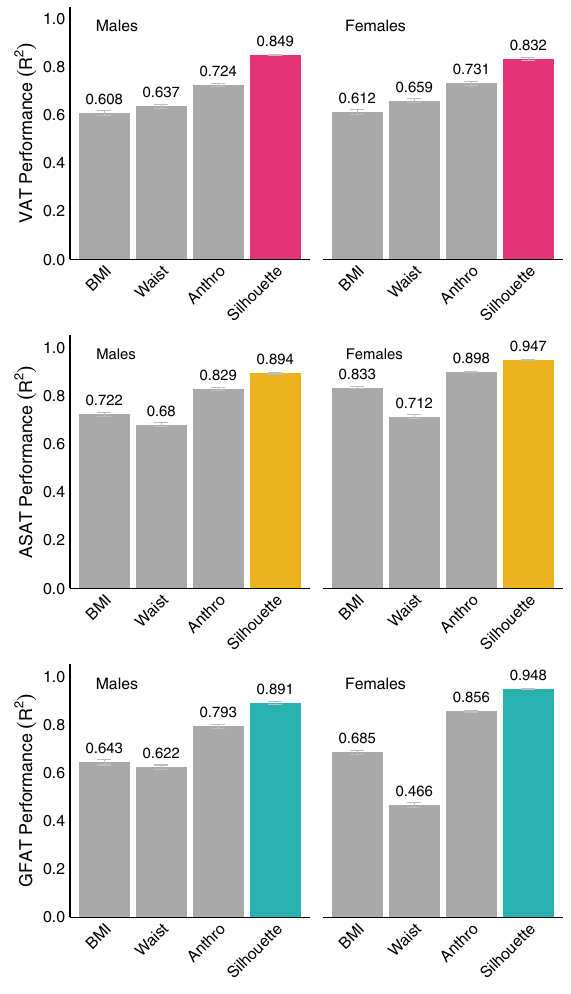
Fig. 2 Silhouettes outperform anthropometric models in predict- ing VAT, ASAT, and GFAT volumes. Sex-speci fi c linear models combining age and various anthropometric metrics measured at the time of imaging were compared to a linear model combining age and silhouette-predicted fat volume (Supplementary Data 5 and 6). Model de fi nitions; BMI: age + BMI; Waist: age + waist circumference; Anthro: age + weight + height + BMI + waist circumference + hip circumference + waist-hip ratio + body impedance measures; Sil- houette: age + silhouette. Error bars represent 95% con fi dence intervals obtained from bootstrapping with 1000